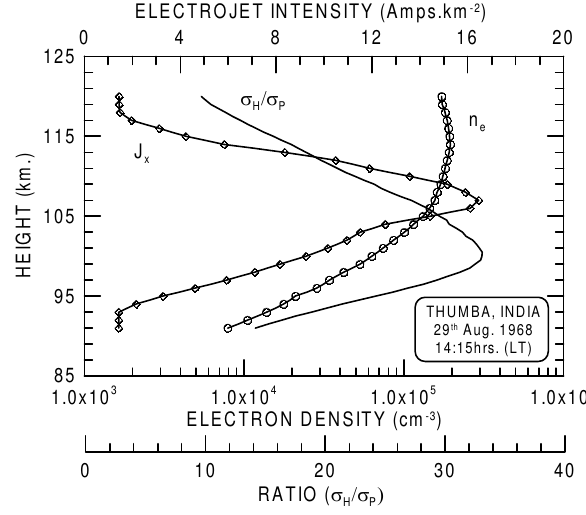
Fig. 3. Height profiles of the electron density and electrojet current intensity estimated from in-situ measurements made from Thumba, India at 14:15 LT on 29 August 1968 (Flight 20.07), compared with the model estimate of the ratio of Hall to Pedersen conductivity pro- file.